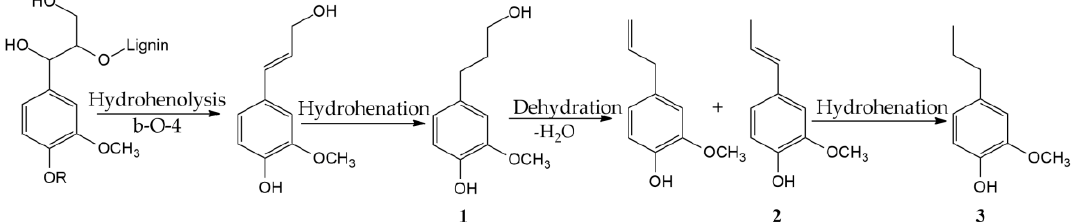
Figure 4. Scheme of the propylguaiacol formation through the cleavage of the β -O-4-bonds and subsequent hydrogenation and dehydration of coniferyl alcohol.